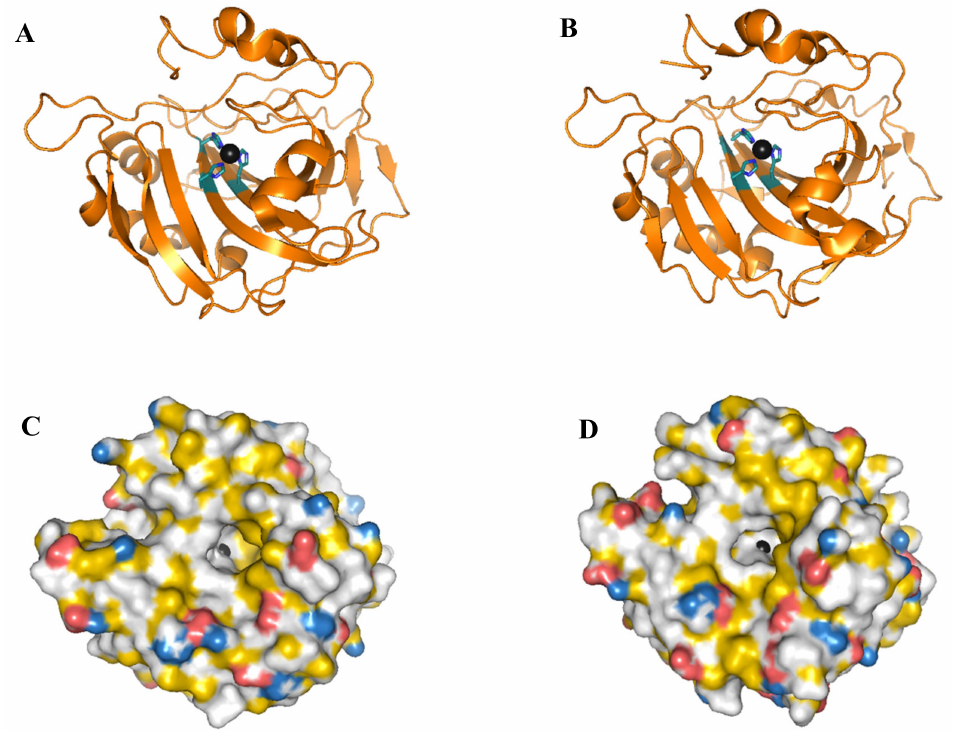
Figure 1. ( A , C ) hCA I, and ( B , D ) hCA II (wild type), shown as cartoon images ( A , B ) and space-filled images ( C , D ). The zinc ion is shown as a circle in black and the side chains of the three histidines that coordinate the zinc ion are shown in ball and stick. The lower figures show a spaced filled model of the proteins colored according to a YRB scheme [39]. (Red) oxygen atoms in D and E side chains. (Blue) nitrogen atoms in R and K side chains. (Yellow) part of the protein with high potential to form hydrophobic interactions. Images were prepared from pdb: 2cab [40] and 2ili [41] for hCA I and hCA II, respectively, using the PyMOL Molecular Graphics System, Schrödinger,